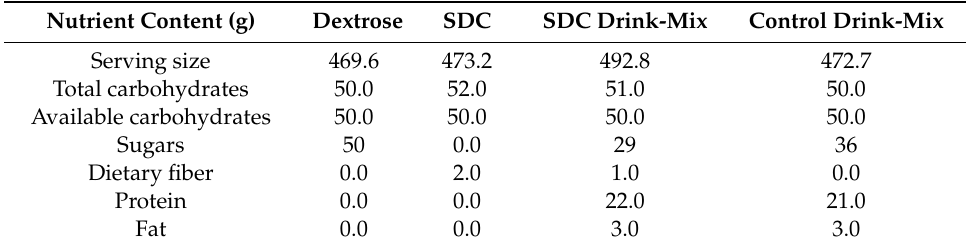
Table 1. Nutrient composition of slowly digestible carbohydrates (SDC) alone and in powdered drink-mix. Nutrient Content